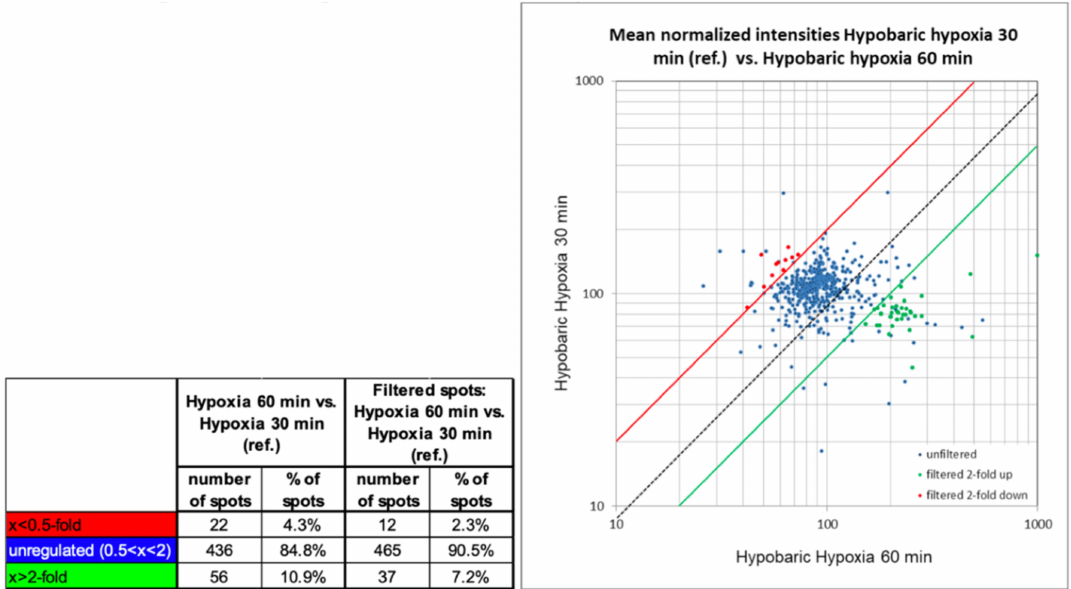
Figure 9. Summary of quantitative changes of comparison 3: HH60 versus HH30. Spot intensities prior and after filtering (for details, see